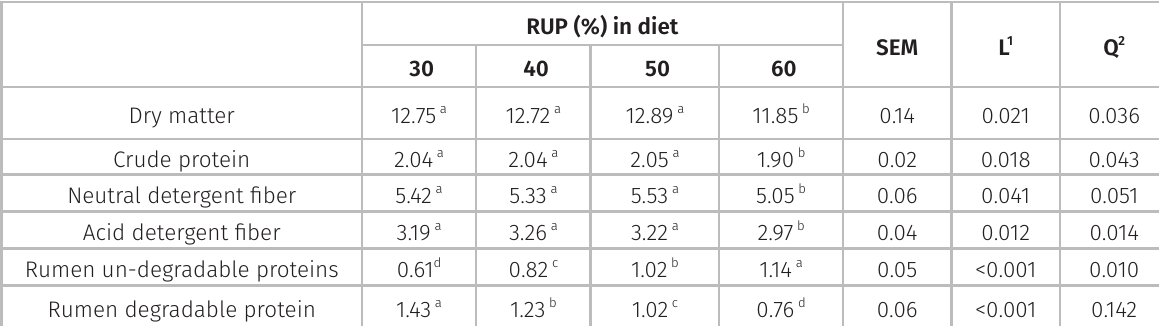
Table II. Daily nutrients intake of cross bred (Friesian×Jersey) dairy cattle fed diets with various levels of rumen undegradable protein